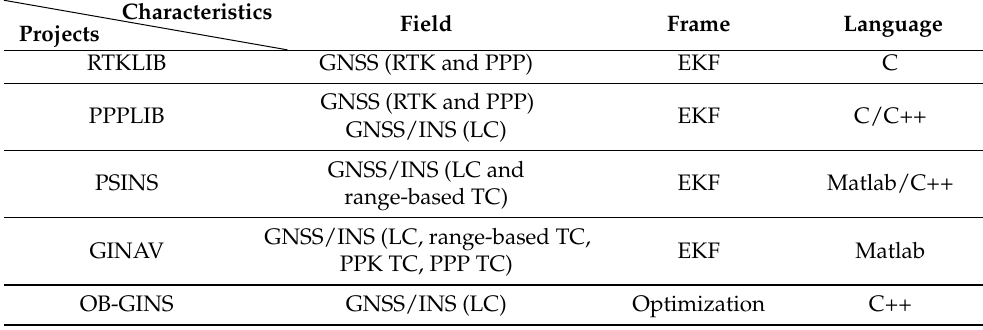
Table 2. The characteristics of open-source projects. Characteristics Field Frame Language Projects RTKLIB GNSS (RTK and